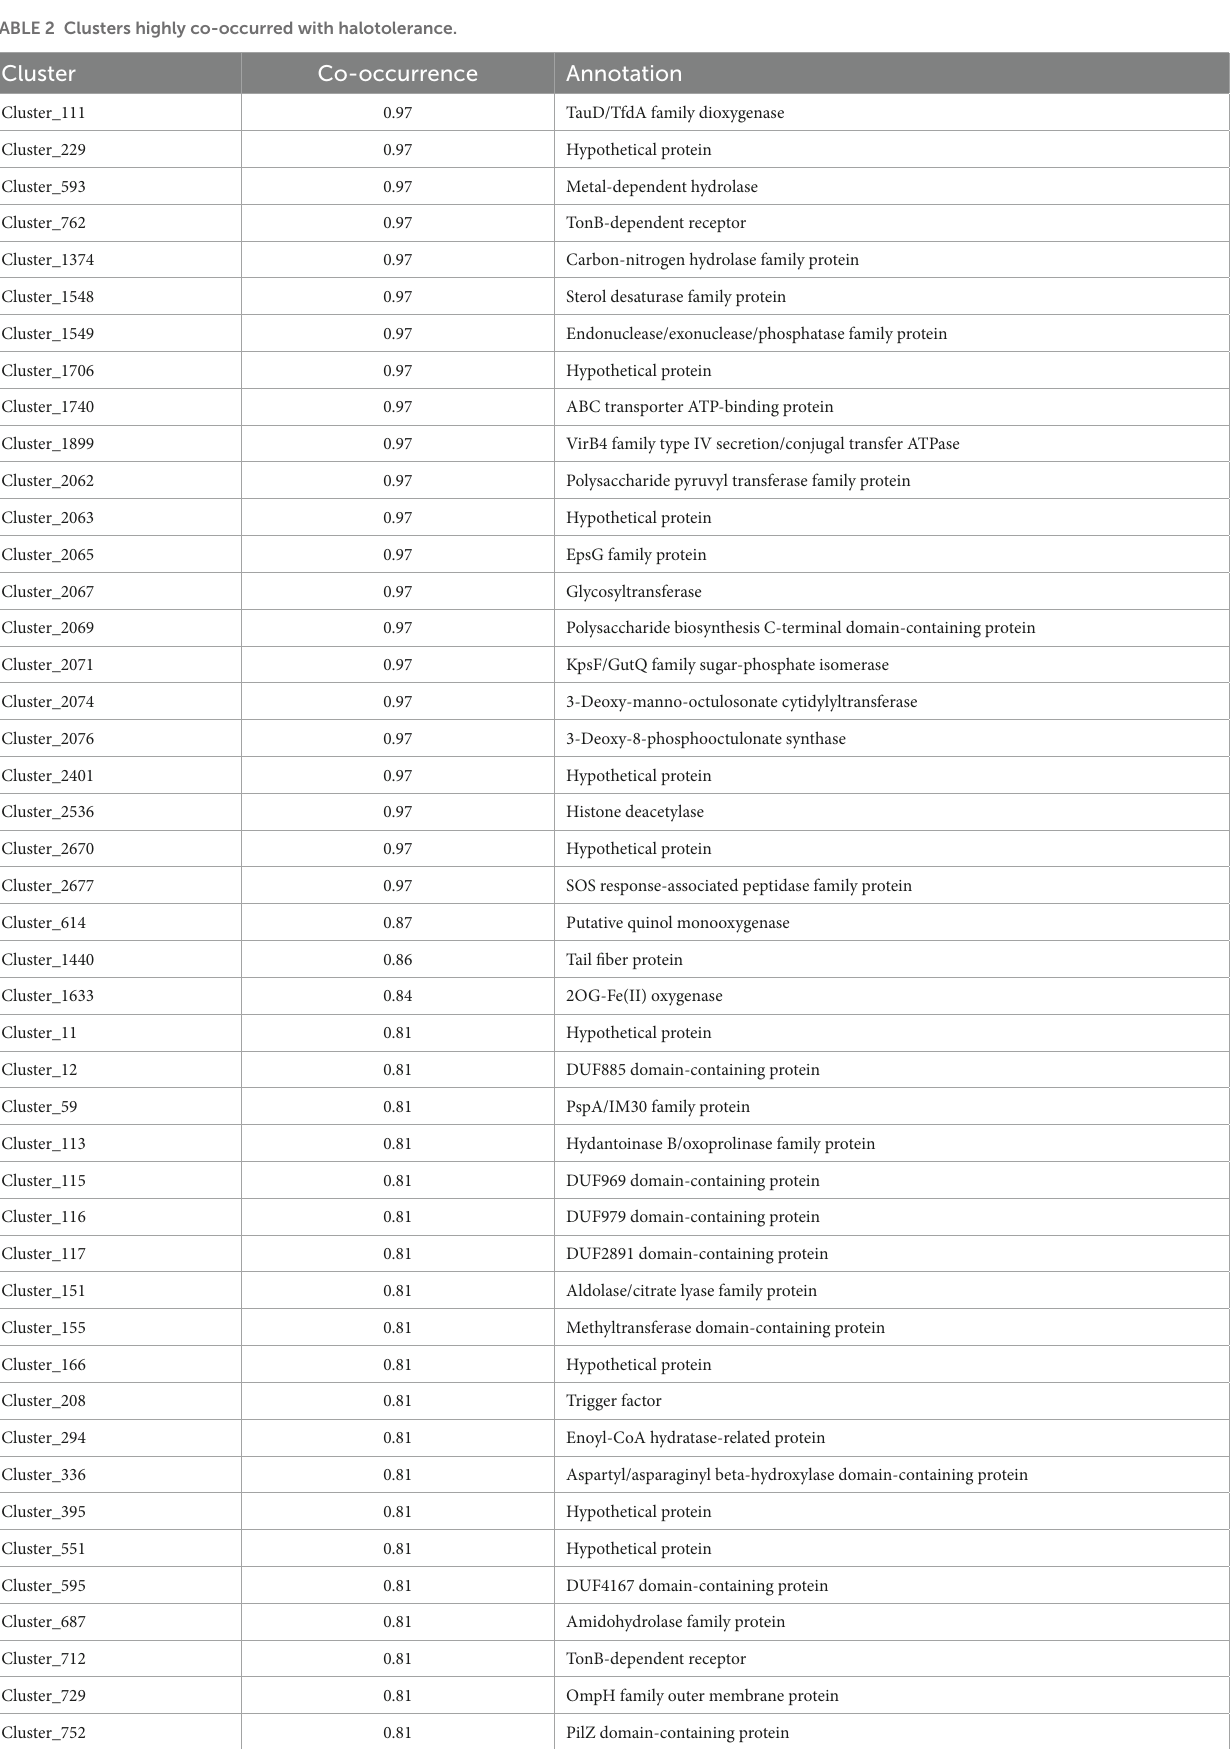
TABLE 2 Clusters highly co-occurred with